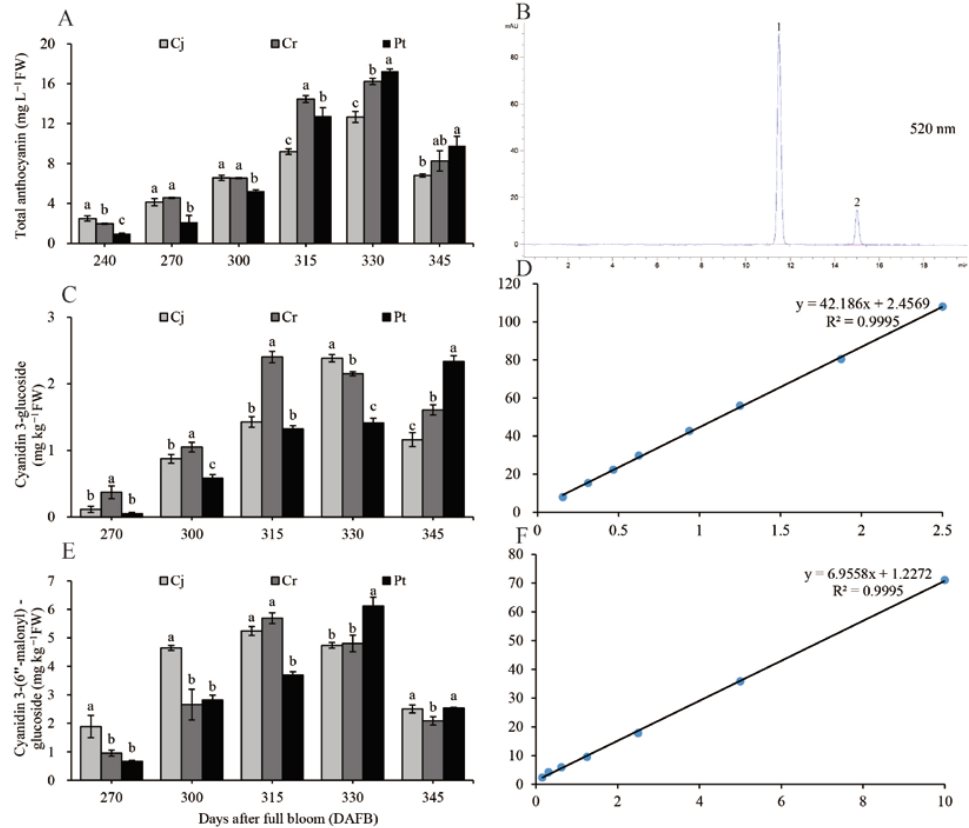
Figure 5. Dynamic changes in total anthocyanin and its compositions of blood orange grafted onto different rootstocks during fruit development and ripening: ( A ) dynamic changes of the total anthocyanin content; ( B ) HPLC separation of individual anthocyanins monitored at 520 nm; ( C ) dynamic changes of C3G; ( D ) regression equation with a correlation coefficient of C3G; ( E ) dynamic changes of CMG; ( F ) regression equation with a correlation coefficient of CMG. Peaks numbered 1 and 2 in ( B ) correspond to C3G and CMG, respectively.